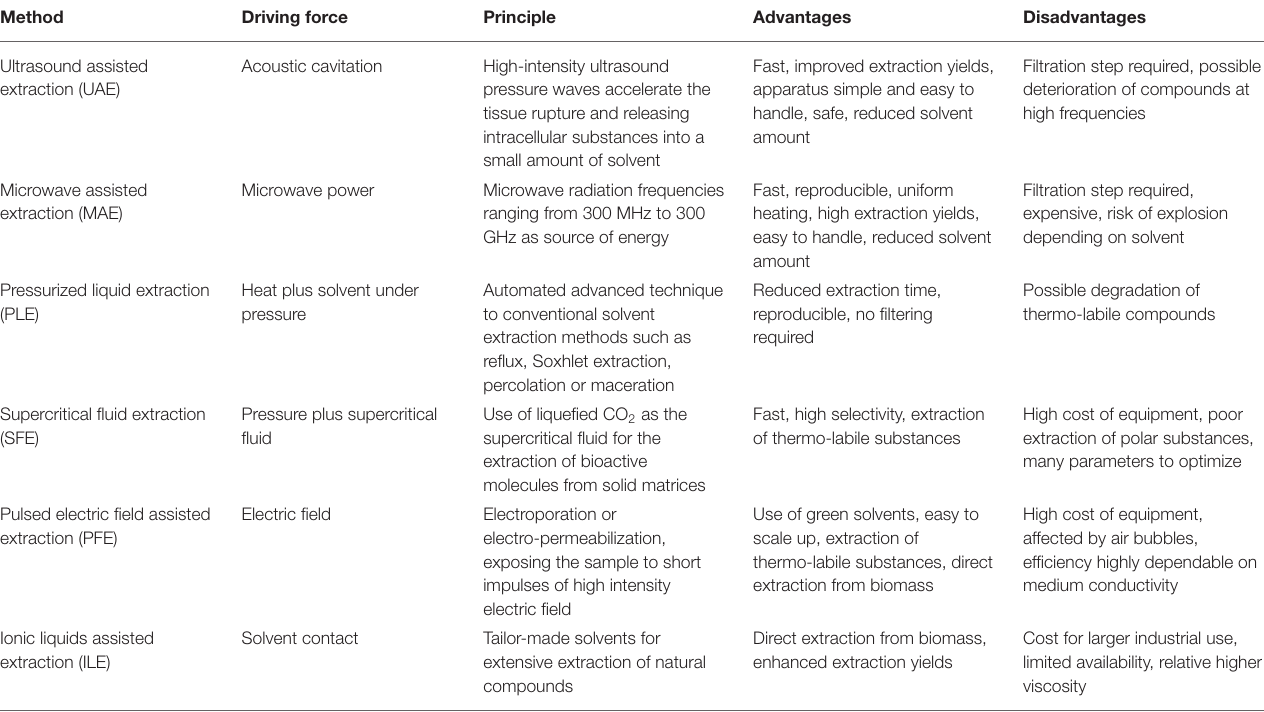
TABLE 2 | Green methodologies for microbial pigment extraction a